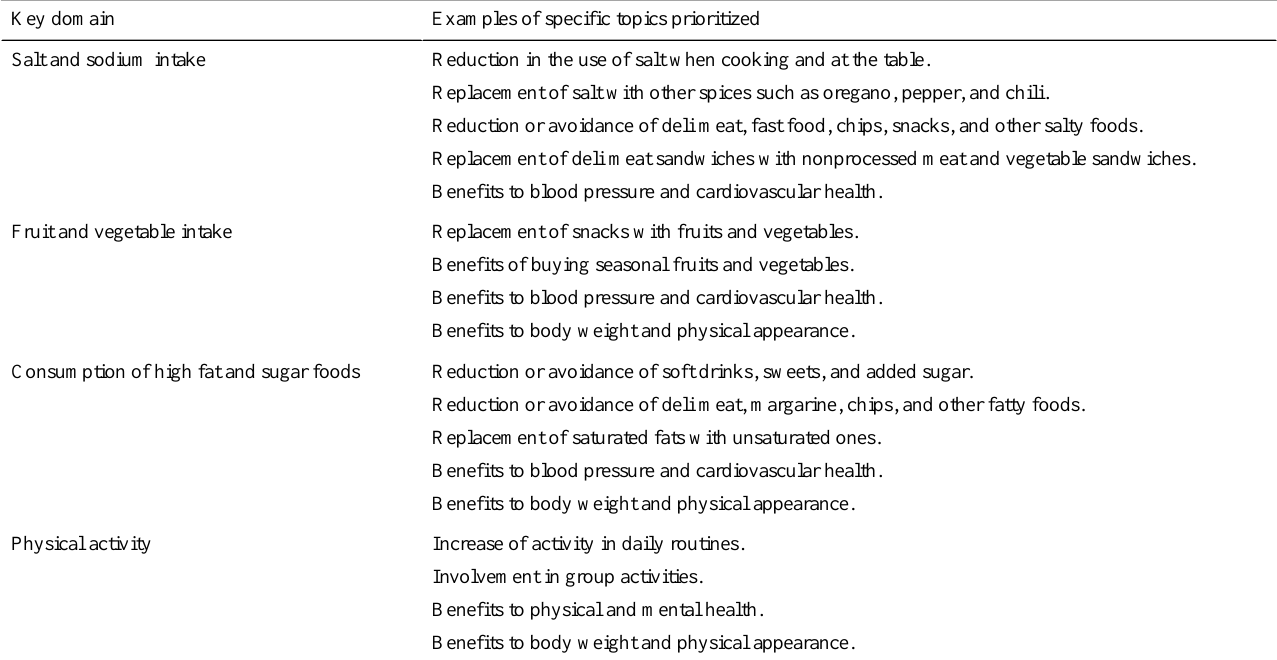
Table 2. Selected key domains and examples of specific topics prioritized in the design of SMS text messages. Examples of specific topics prioritizedKey domain Reduction in the use of salt when cooking and at the table. Replacement of salt with other spices such as oregano, pepper, and chili. Reduction or avoidance of deli meat, fast food, chips, snacks, and other salty